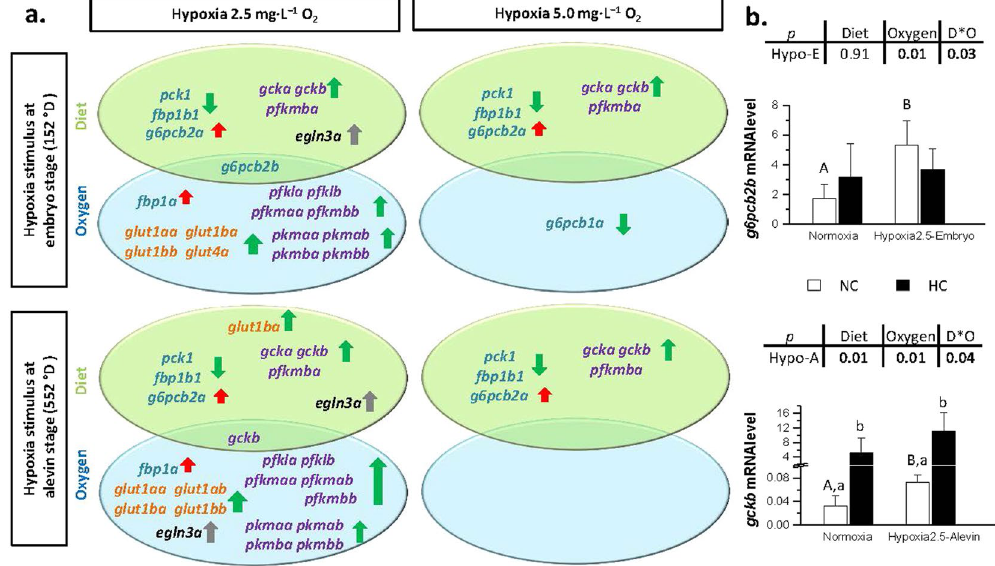
Figure 2. An overview of the effects of oxygen and diet on the mRNA levels of glucose metabolism-related genes and egln3 genes in trout at first-feeding. ( a ) mRNA levels of genes significantly affected by high carbohydrate diet (green oval) or by the hypoxic stimulus (blue oval) at first-feeding. Genes written in blue, purple and orange belong to gluconeogenic, glycolytic and glucose transport pathway, respectively. Arrows represent up- or down- modulation of the mRNA level, with green colour in favour of glucose expenditures and red colour in favour of glucose production. ( b ) Effect of interactions between the early hypoxic stimulus and the high carbohydrate diet on mRNA levels of g6pcb2b and gckb in trout at first-feeding. White and black bars stand for trout fed the no carbohydrate (NC) or the high carbohydrate (HC) diet at first-feeding, respectively. Hypo-E and Hypo-A stands for trout subjected to hypoxic stimulus at embryo or alevin stage, respectively. Data are presented as the mean ± SD (n = 6), and significant differences were evaluated by two-way ANOVA followed by a subsequent one-way ANOVA analysis ( p < 0.05). Capital and lowercase letters indicate the significant effect ( p < 0.05) of early hypoxic stimulus or high carbohydrate diet within their corresponding groups,